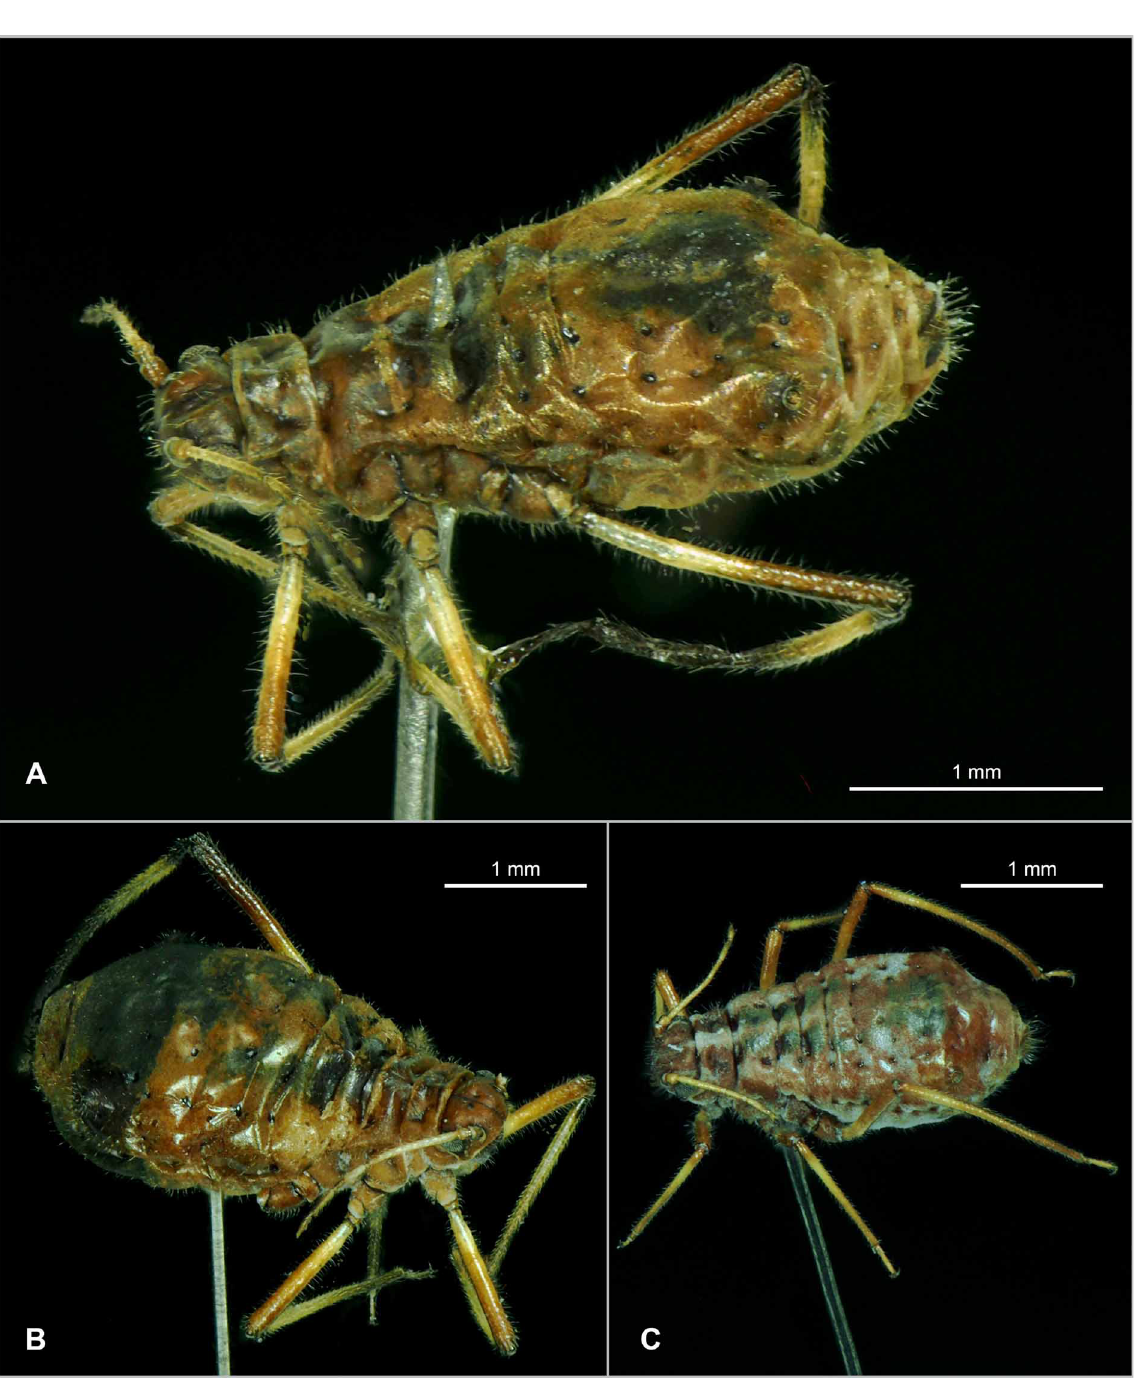
Fig. 89. Cinara (Cinara) pini (Linnaeus, 1758). Freeze-dried apterae. A–B . Adults. C . Full-grown